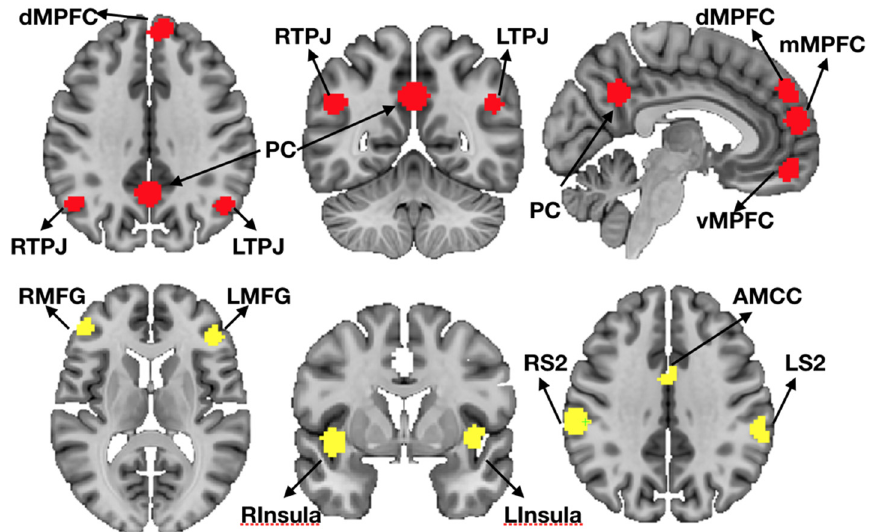
Figure 2. Regions of interest displayed on the MNI template (displayed in 2.5 mm space). Regions comprising the ToM network (upper row, in red): (dorsal (d)/ventral (v)/middle (m) medial pre- frontal cortex (MPFC), precuneus (PC), right temporal-parietal junction (RTPJ), left temporal-parietal junction (LTPJ); and the “Pain Matrix” network (lower row, in yellow): anterior mid-cingulate cortex (AMCC), right insula (RInsula), left insula (LInsula), right middle frontal gyrus (RMFG), left middle frontal gyrus (LMFG), right secondary somatosensory cortex (RS2), left secondary somatosensory cortex (LS2)).